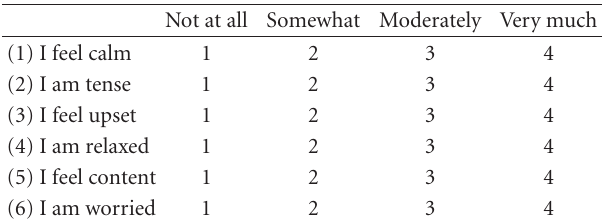
Table 1: Short STAI (state-trait anxiety